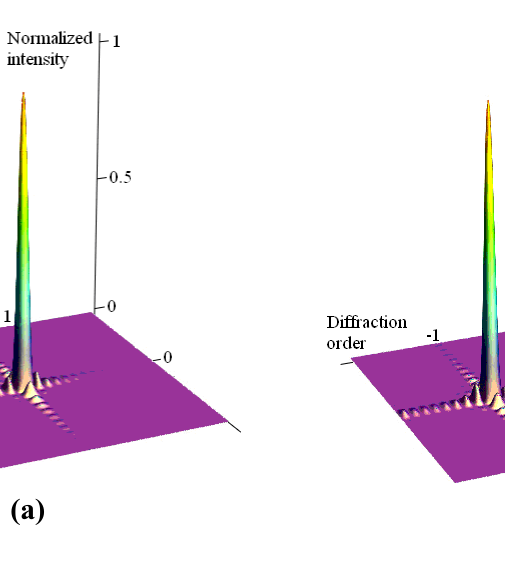
2n' π . (b) The phase difference is (2n'+1) π